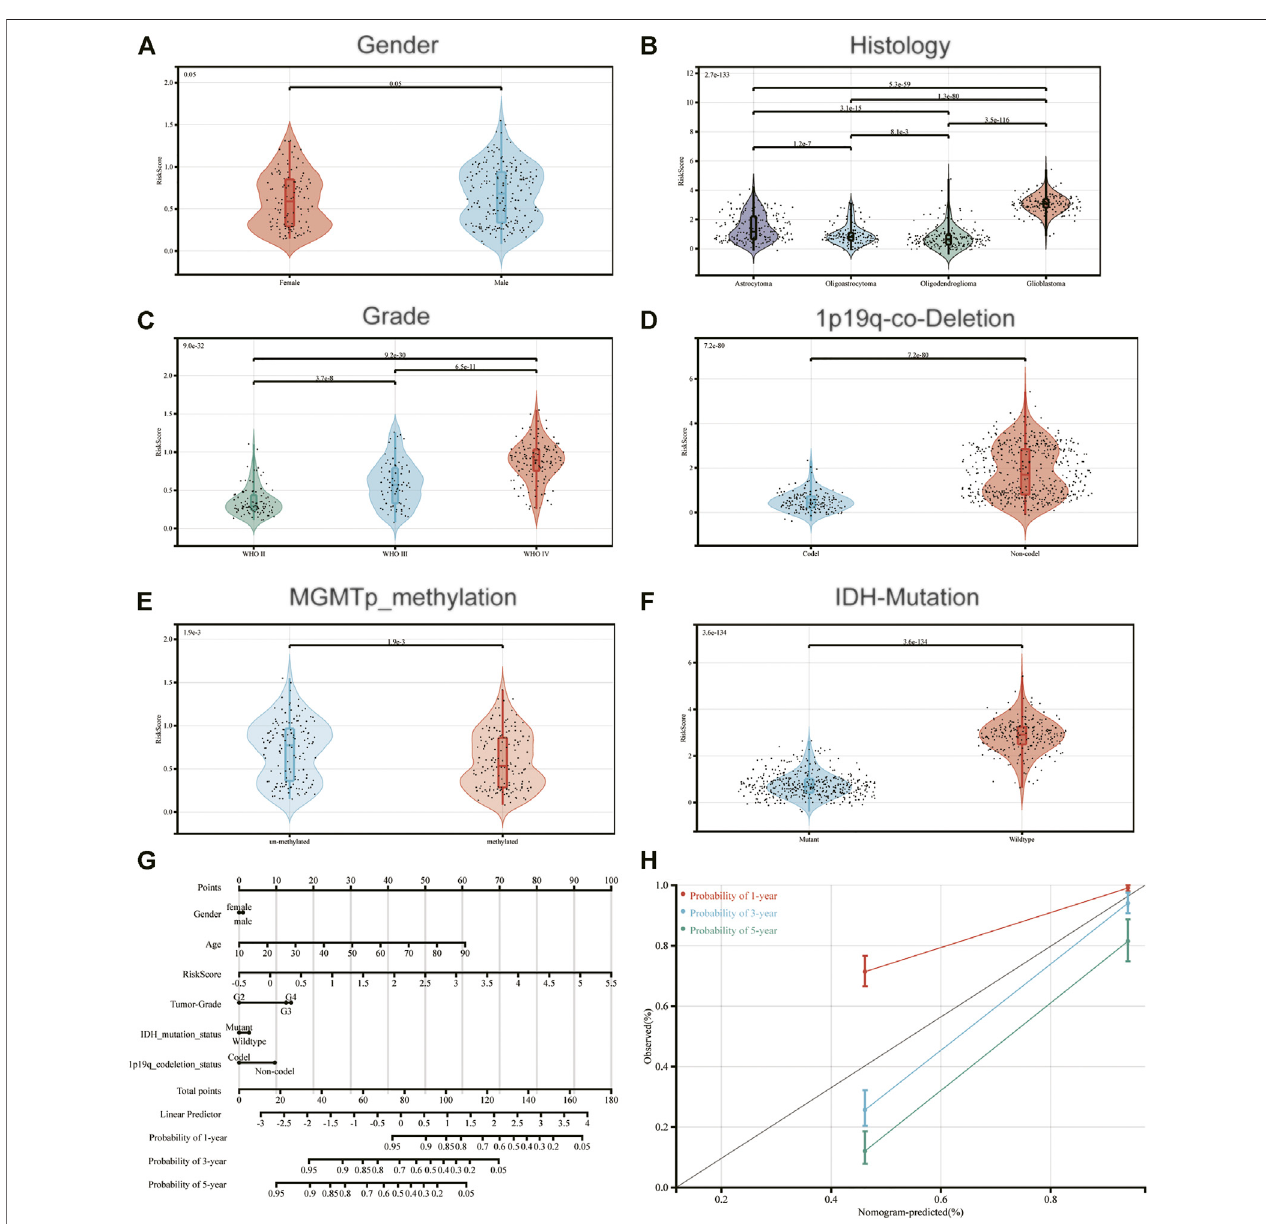
FIGURE3| Associationbetweentheconstructedimmune-relatedsignatureand (A) Gender; (B) Histology; (C) Grade; (D) 1p19q-co-Deletion-Status; (E) MGMTp- methylation-statusand (F) IDH-Mutation-Status. (G) Anomogramtopredict1-,3-and5-yearOS; (H) Calibrationcurvesdeterminedusinganomogram todemonstrate the consistency between predicted and detected 1-, 3- and 5-year